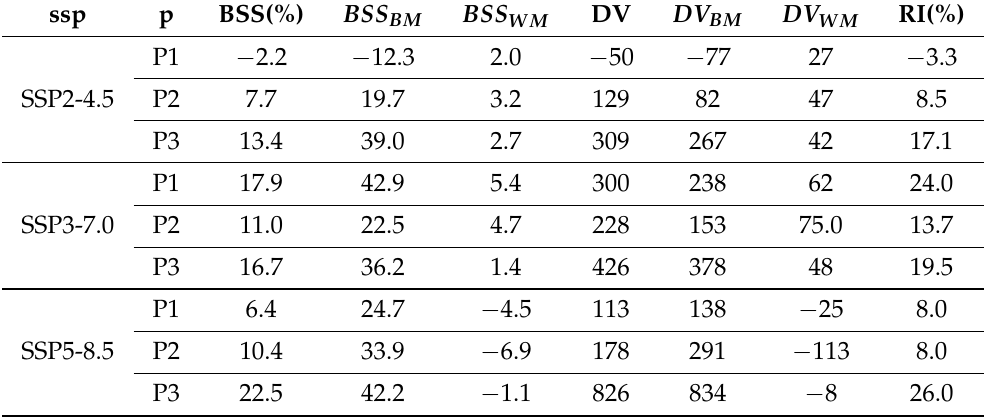
Table 4. The averaged values of the Brier skill scores (BSSs), averaged differences of variances (unit: mm 2 ) of the 20-year return level over 46 grid points in the Korean peninsula, and relative improvements (RIs) of the PI-weighted method over the simple average (last column) for the three − V PI periods and for the three scenarios. RI = V Eq V